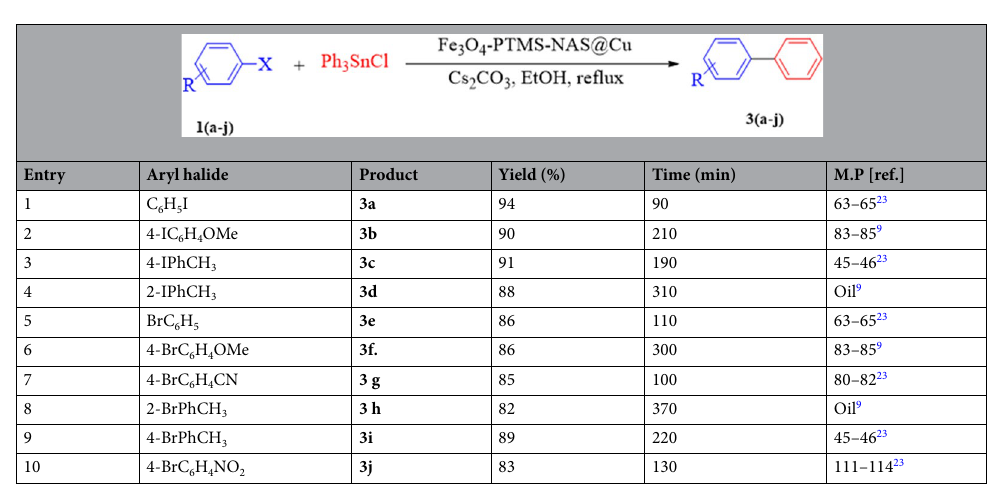
Table 3. Synthesis of biphenyl derivatives by the Stille reaction in presence of Fe 3 O 4 -PTMS-NAS@Cu MNPs. Reaction conditions: Aryl halide (1 mmol), triphenyltin chloride (0.4 mmol), CS 2 CO 3 (1 mmol), Fe 3 O 4